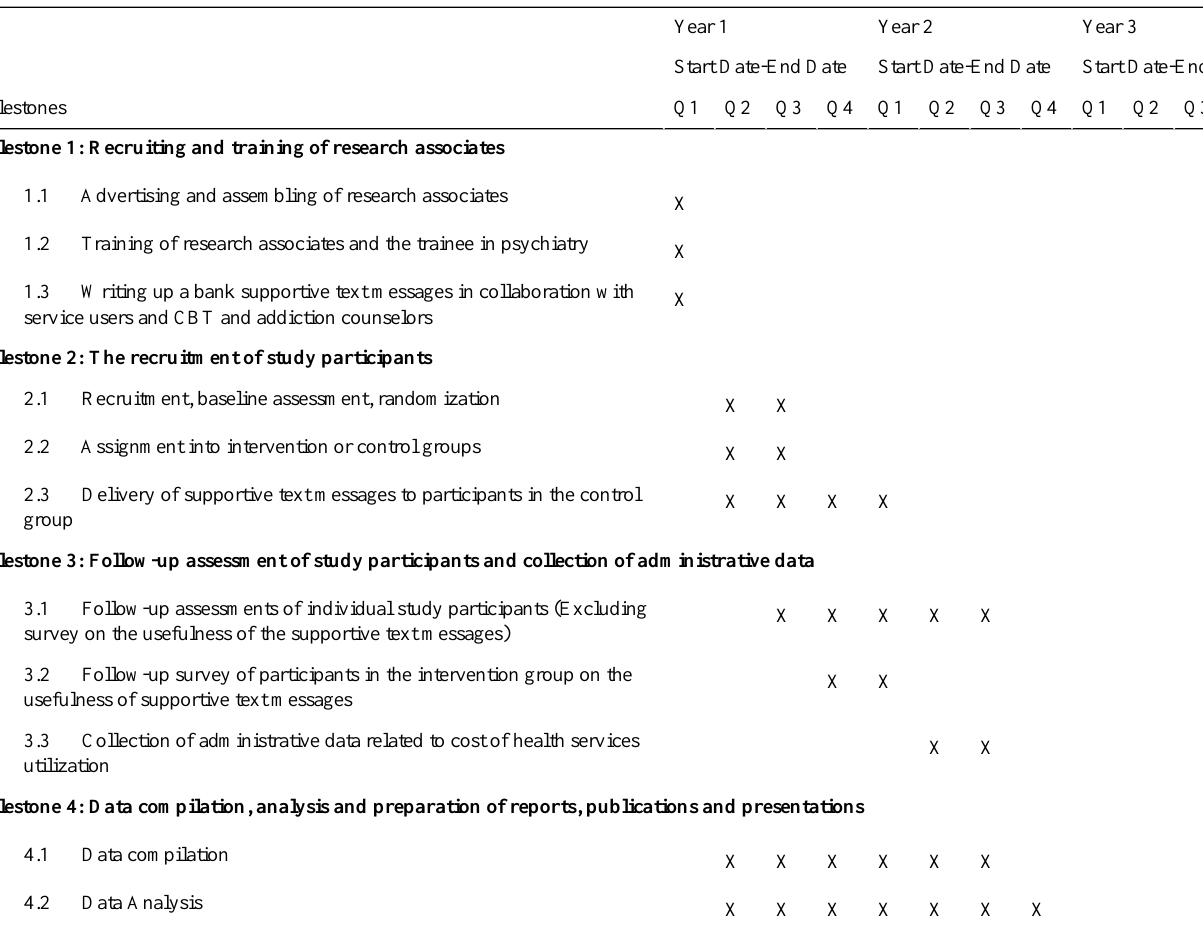
Table 1. Gantt chart for supportive text message